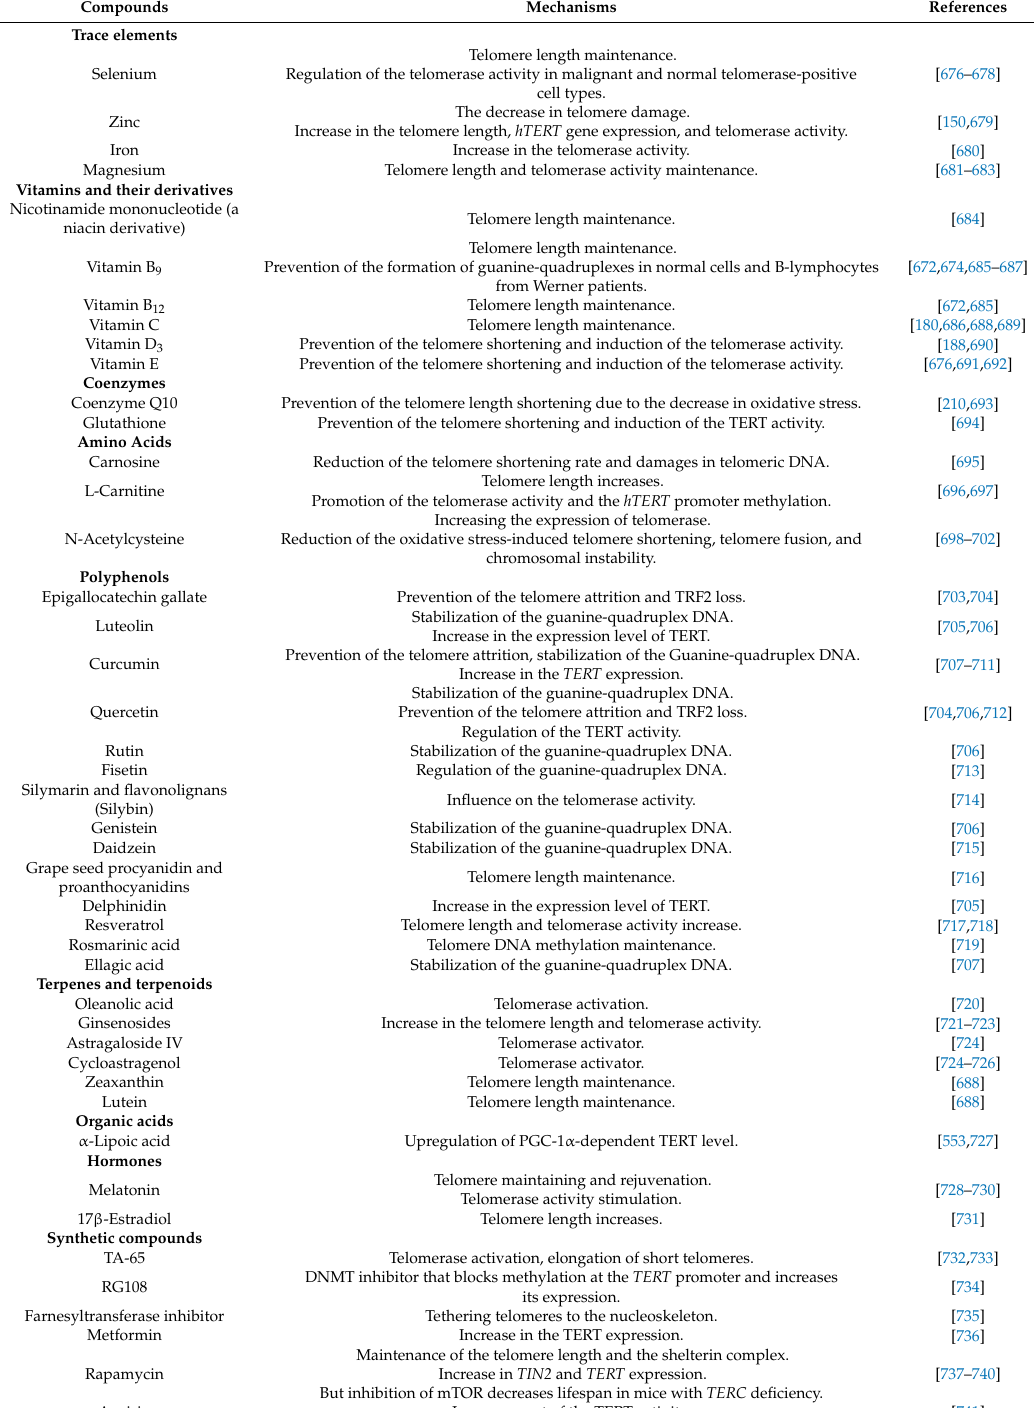
Table 2. Compounds preventing DNA damage due to epigenetic regulation, telomere maintenance, and nuclear architecture